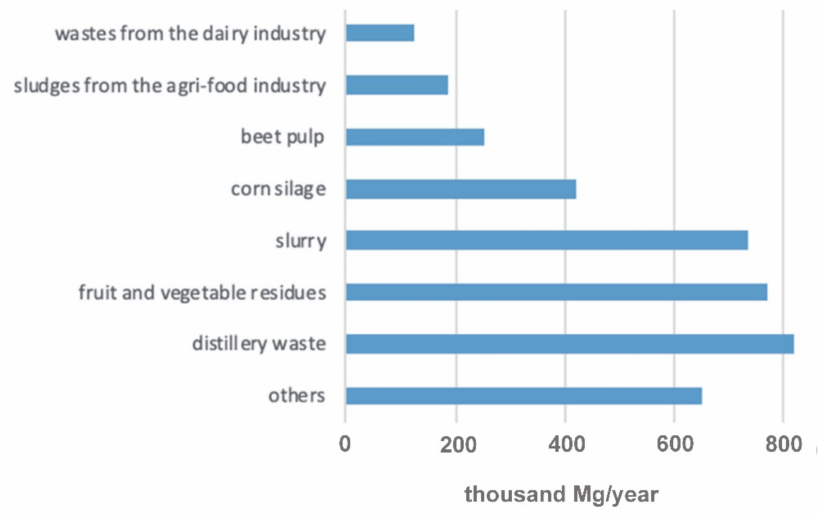
Figure 5. Raw materials applied in agricultural BG plants in Poland (Mg); own elaboration based on [32].